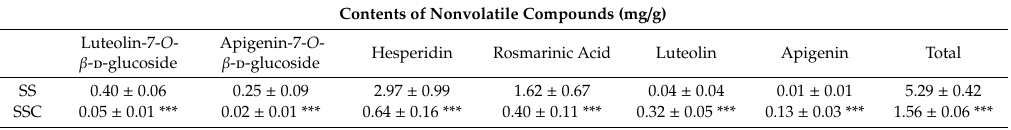
Figure 5. Representative HPLC chromatograms of SS and SSC samples. 1, luteolin-7- O - β - d -glucoside; 2, apigenin-7- O - β - d -glucoside; 3, hesperidin; 4, rosmarinic acid; 5, luteolin; and 6, apigenin. Table 3. Nonvolatile compound contents of SS and SSC.